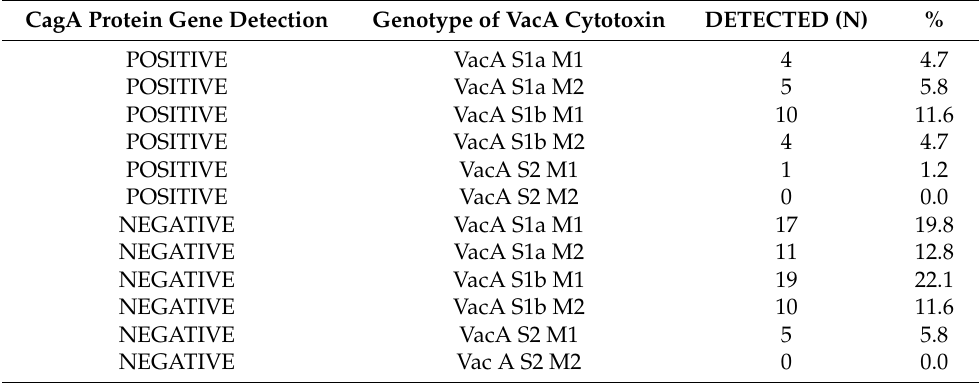
Table 5. Distribution of different Helicobacter pylori genotypes in positive samples of the respective groups (malignancy, n = 86).